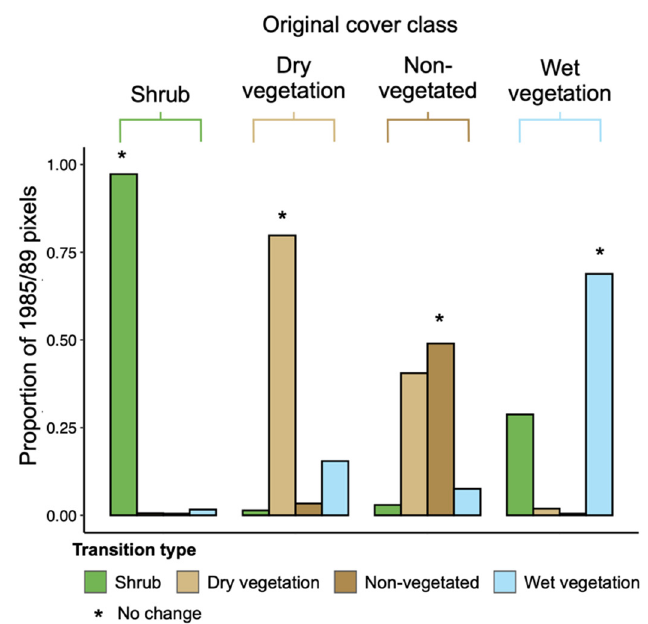
Figure 2. Proportion of pixels transitioning between land cover classes from 1985/89 to 2015/19. Bars are grouped by the original (1985/89) cover class and transitions are indicated by colors; ‘*’ indicates the case where pixels remained in the same cover class between time periods.